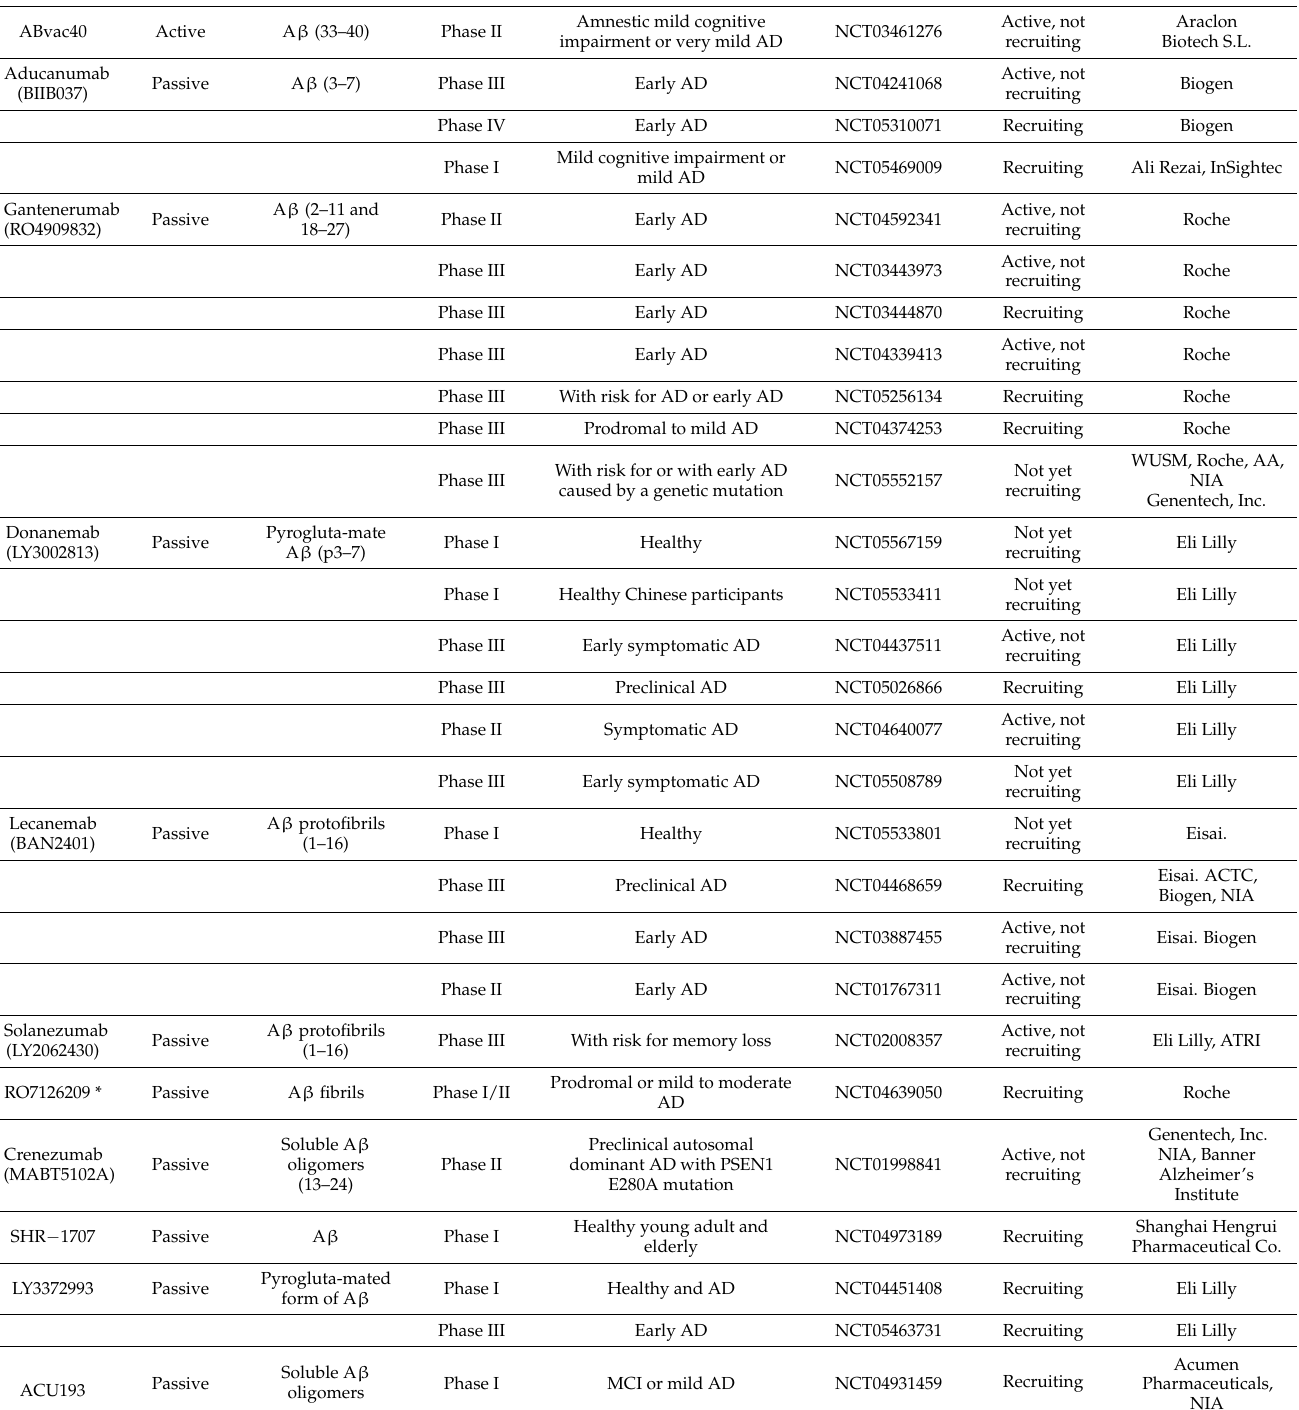
Table 1. Current ongoing clinical trials for A β immunotherapy (Clinicaltrials.gov, as of 1 October